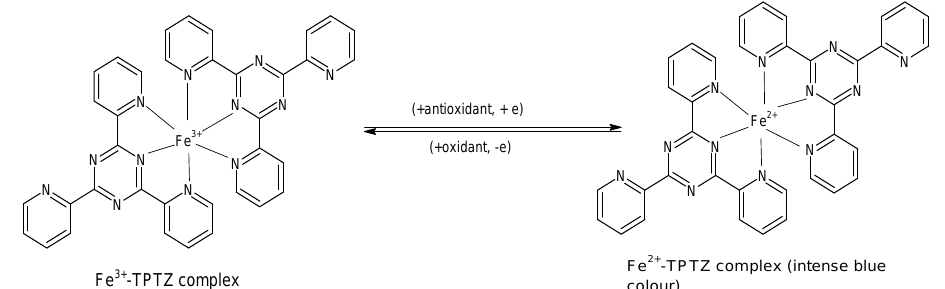
Figure 2. Reaction of ferric tripyridyl-S-triazine complex with antioxidant to yield the intensely blue ferrous form of the complex at an absorbance maxima of 593 nm. (Chemical structures produced with ACD/ChemSketch Freeware Version 2021.1.0 C25E41).